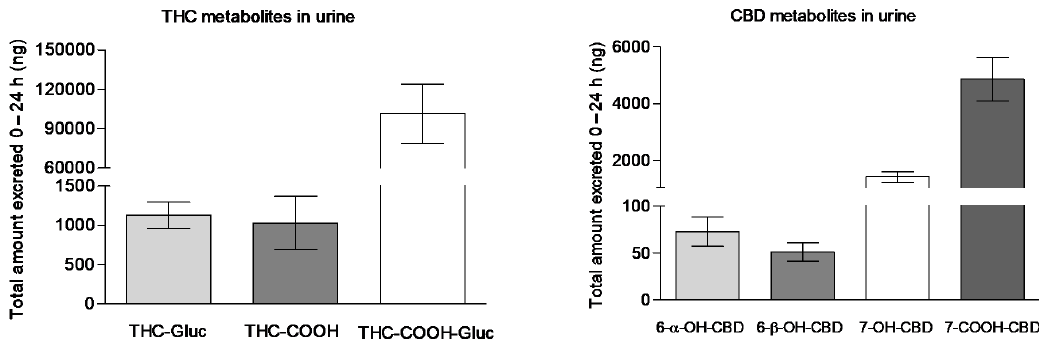
Figure 6. The total amount of THC-GLUC, THC-COOH, THC-COOH-GLUC, and 6- α -OH-CBD, 6- β -OH-CBD, 7-OH-CBD, 7-COOH-CBD excreted in 24 h urine samples following the administration of vaporized medical cannabis.